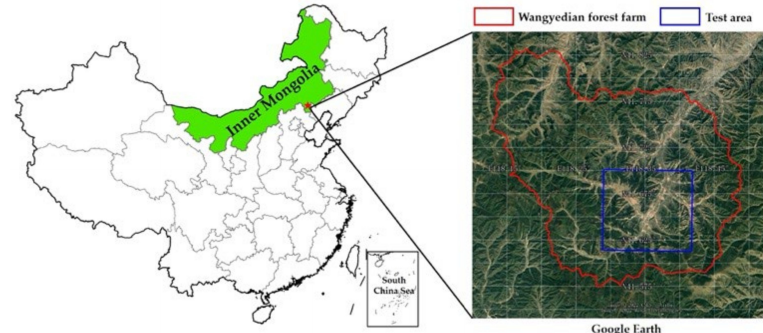
Figure 2. Location of the test site.